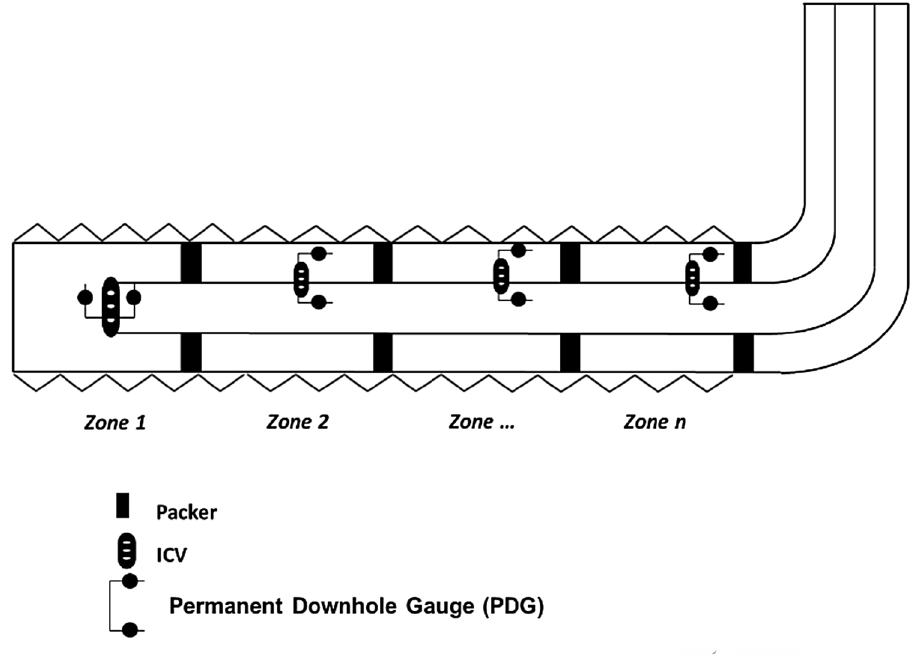
Fig. 5 A schematic of n-zone